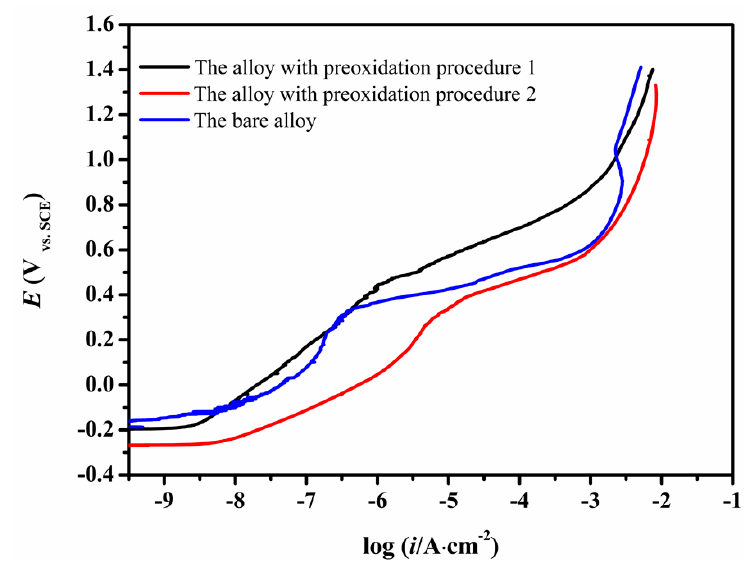
Figure 9. Anodic polarization curves of the bare CMSX-4 sample and the samples obtained following